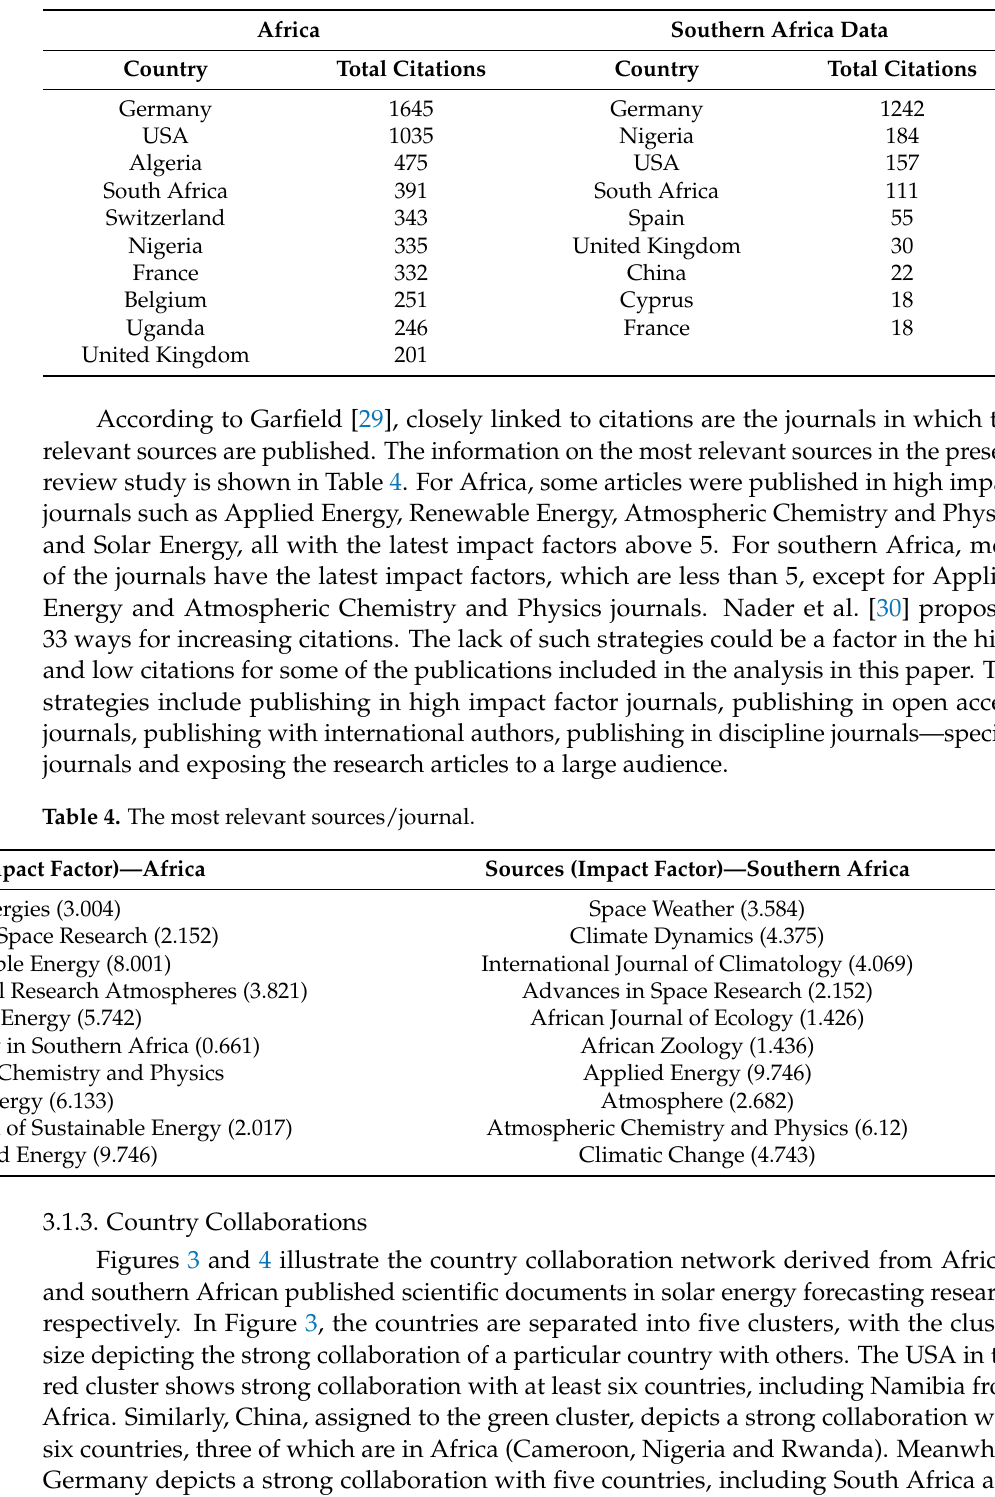
Table 3. The total citations per country.